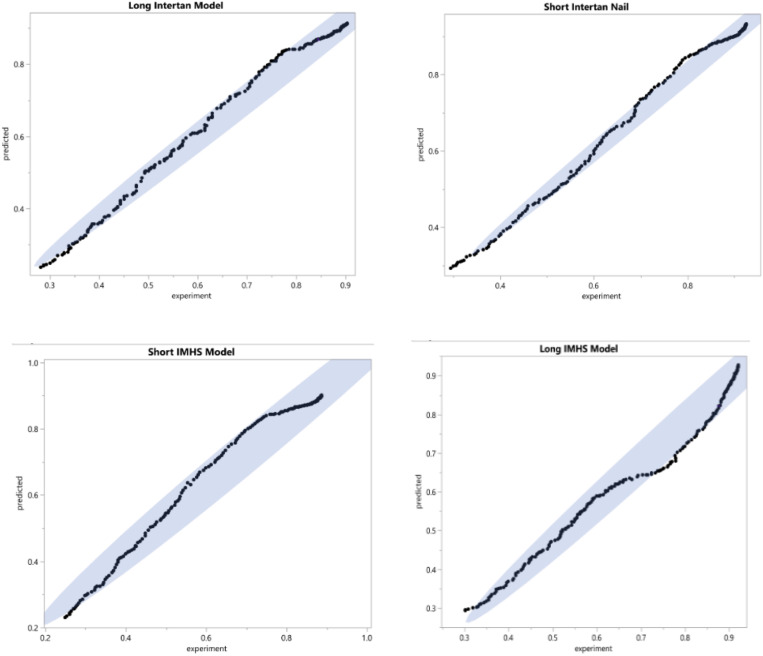
The difference between the experimental data and the predicted data for each type of internal fixation nail constructs (95% confidence interval).